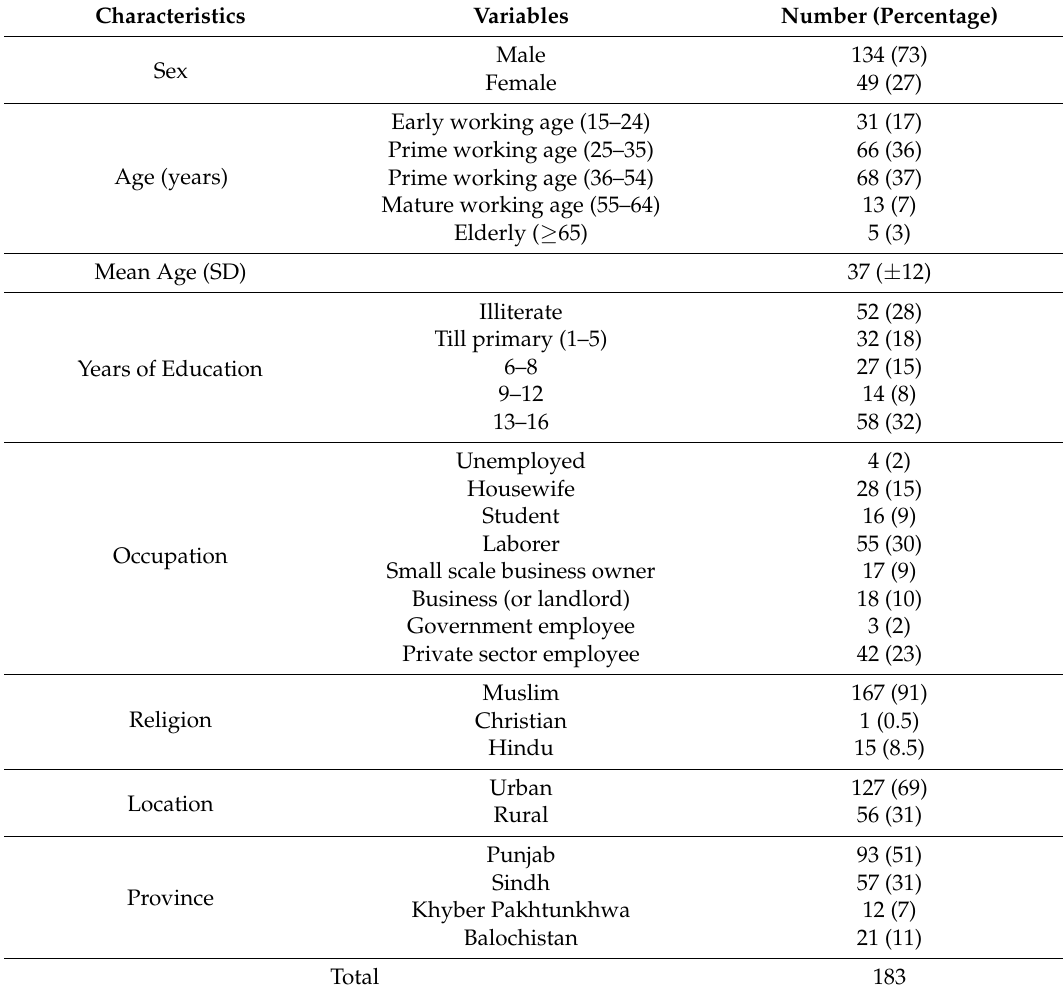
Table 1. Sociodemographic characteristics of study